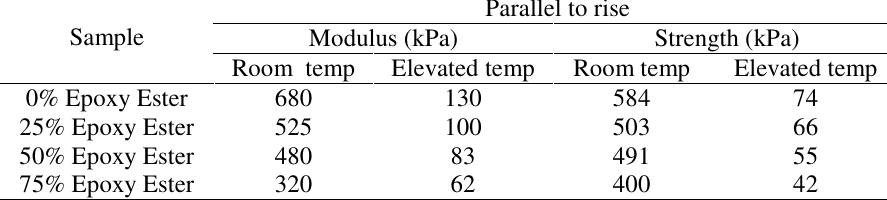
Table 2 . Compressive modulus and strength parallel to rise.